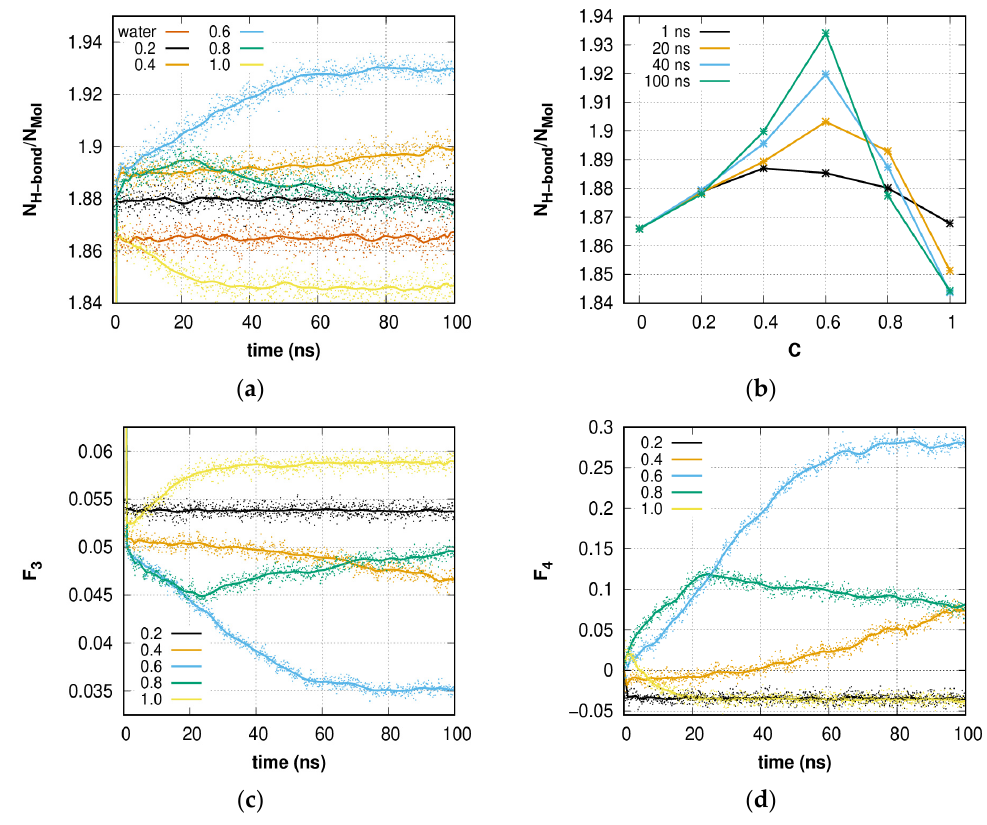
Figure 9. ( a ) Time dependence of H-bond number per water molecule and ( b ) normalized H-bond number as a function of gas concentration at different time points. Time dependence of ( c ) F 3 and ( d ) F 4 order parameters. When t = 0 ns, F 3 = 0.1 for all methane concentrations. Solid lines at ( a , c , d ) represent the smoothed